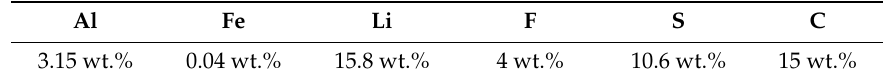
Table 1. Chemical composition of exemplarily cell “LSB 2”, in particular its active mass ( < 1 mm).